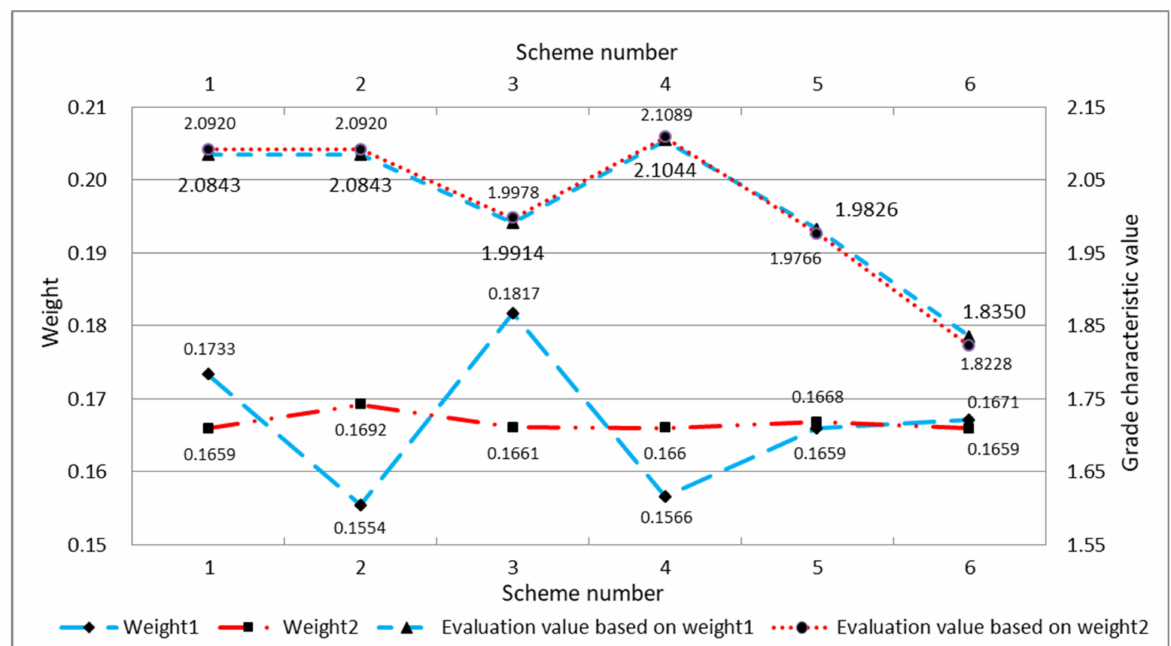
Figure 2. Comparison of the optimal calculation results for two weighted